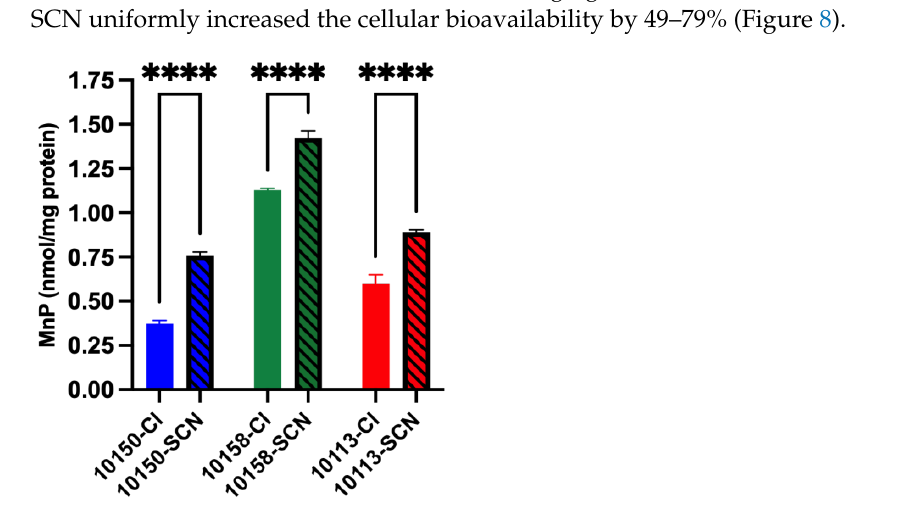
Figure 6. Comparison of the lipid peroxidation inhibition activity levels of chloride ( − Cl) and thiocyanate ( − SCN) formulations of AEOL10150 . The lipid peroxidation of rat brain homogenates was initiated by iron/ascorbate and the lipid peroxides were measured by a thiobarbituric acid re- active species (TBAR) assay. The 50% inhibitory concentrations (IC 50 ) were determined by non-lin- ear regression.